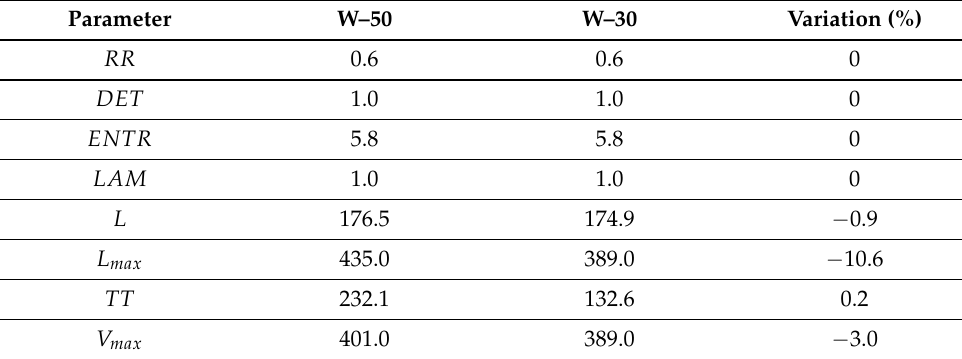
Table 3. RQA quantification for the smoothed Gaussian peaks.